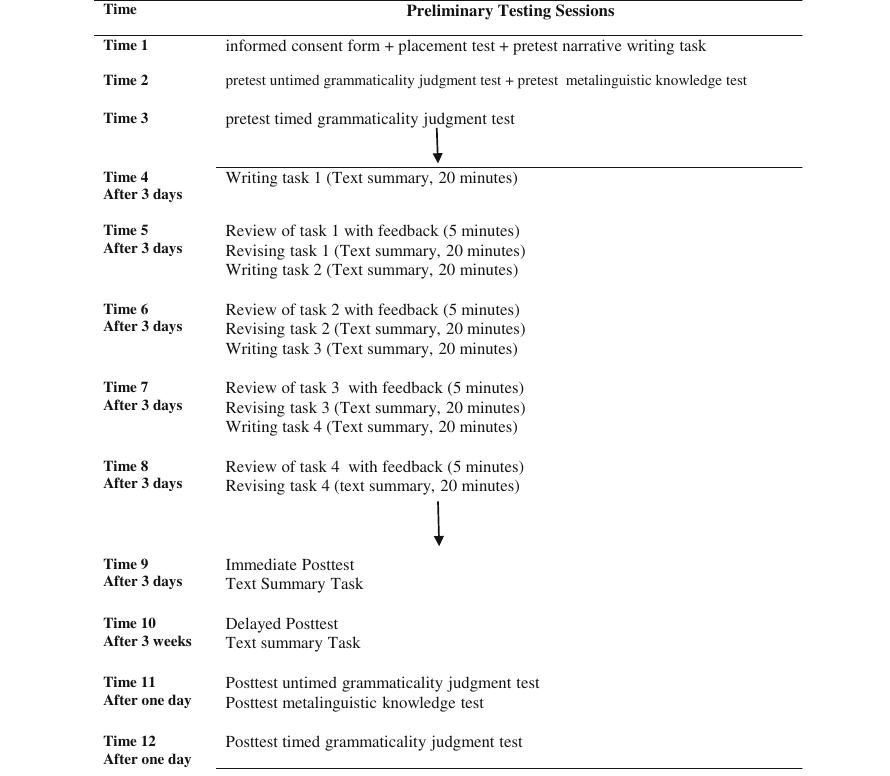
Table 6 represents the descriptive statistics for the narrative writing task and text summary test.